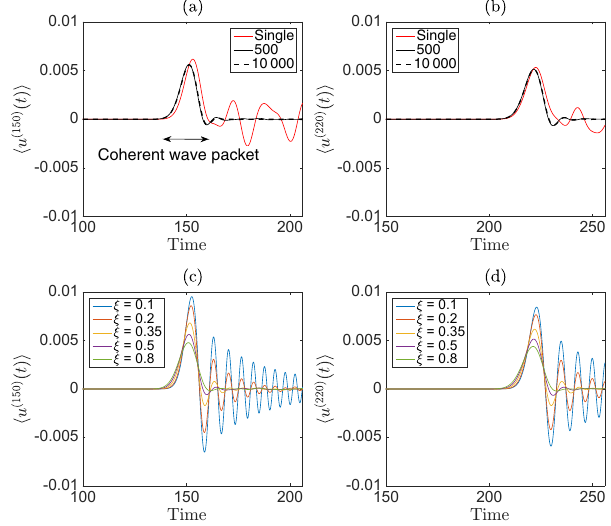
Figure 6. Displacements of 150th (a, c) and 220th (b, d) particle with respect to time for different ensembles (a, b) of disorder ξ = 0 . 5 and of multiple disorder parameters (c, d) ; for 500